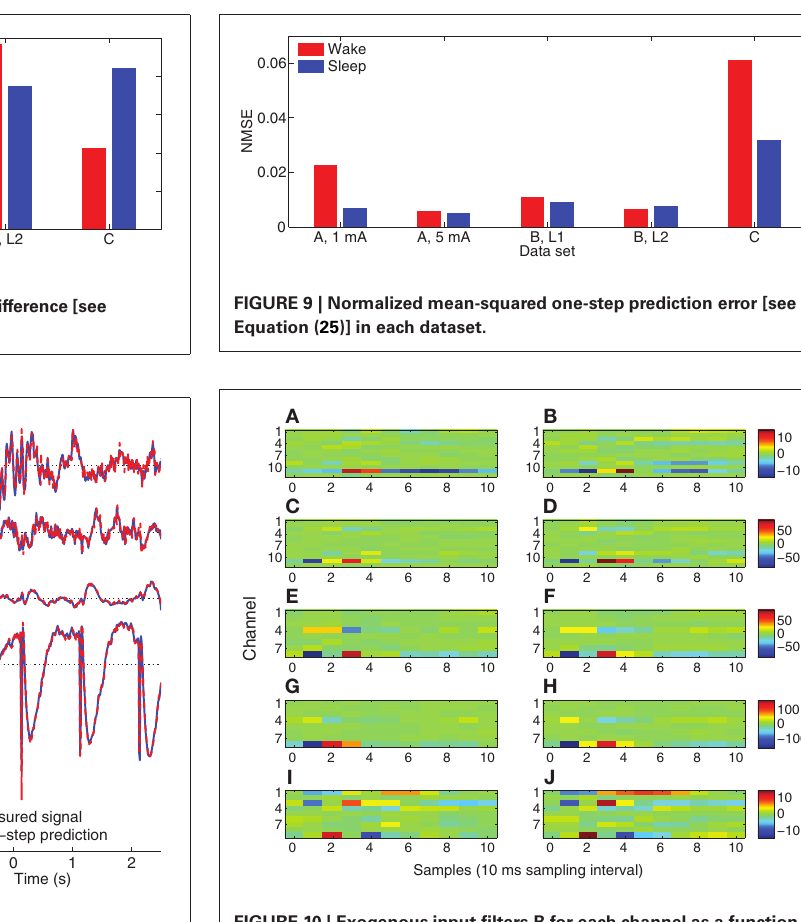
FIGURE 8 | Comparison between recorded signal and one-step prediction of Subject B when the stimulating site is L2. 1.5s pre-stimulus is shown followed by two-and-a-half epochs of evoked data. The black dotted lines in the panels indicate the origin. The model is estimated from data beginning with the fourth epoch. (A) Wake recorded and predicted signals in channels 1, 3, 6, and 8 ordered from top to bottom.